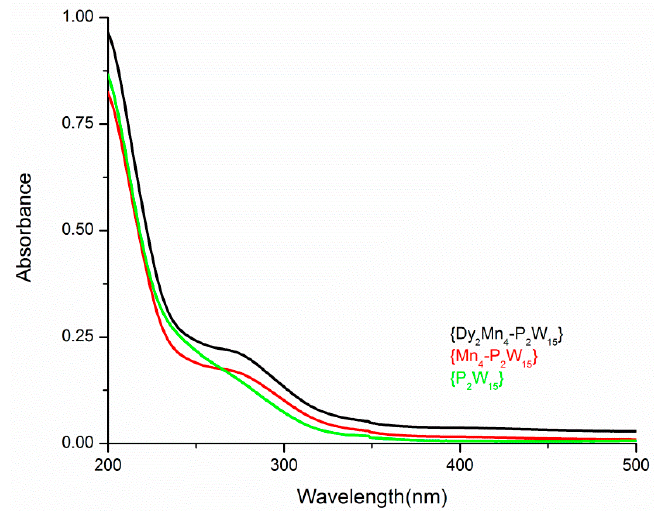
Figure 7. UV-vis spectra Dy 2 Mn 4 -P 2 W 15 , Mn 4 -P 2 W 15 , and P 2 W 15 .